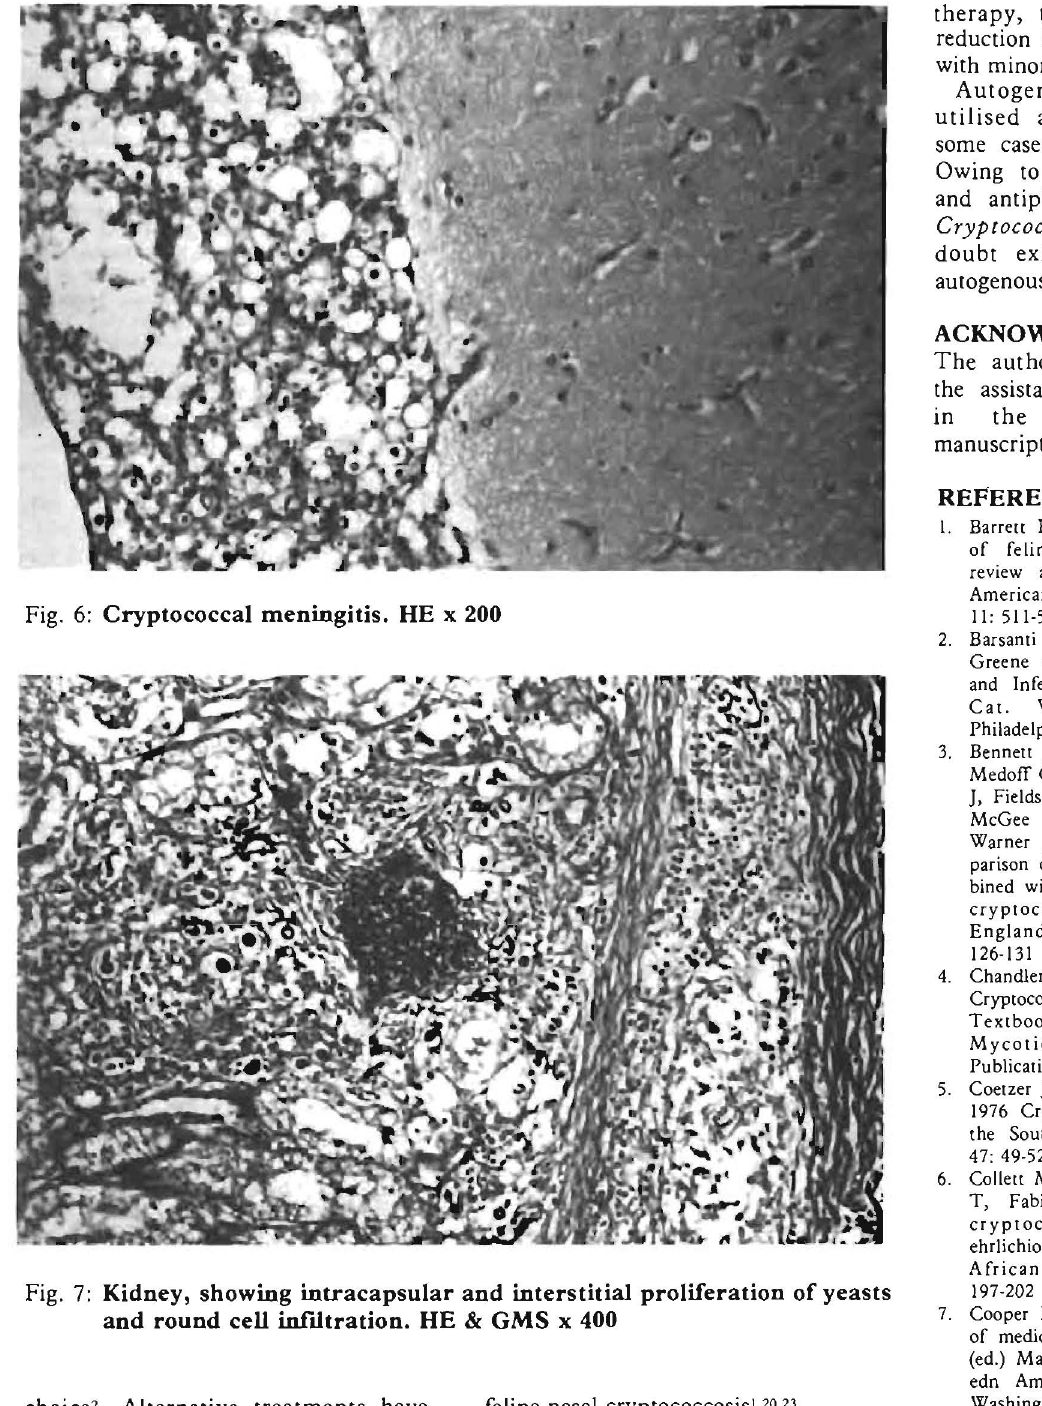
Fig. 7: Kidney, showing intracapsular and interstitial proliferation of yeasts and round cell inf .... ltration. HE & GMS x